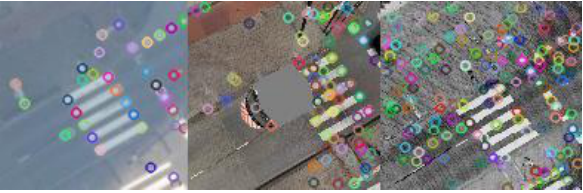
Figure 5 SIFT keypoints detected in aerial image (left), panoramic image (centre) and MLS intensity image (right)